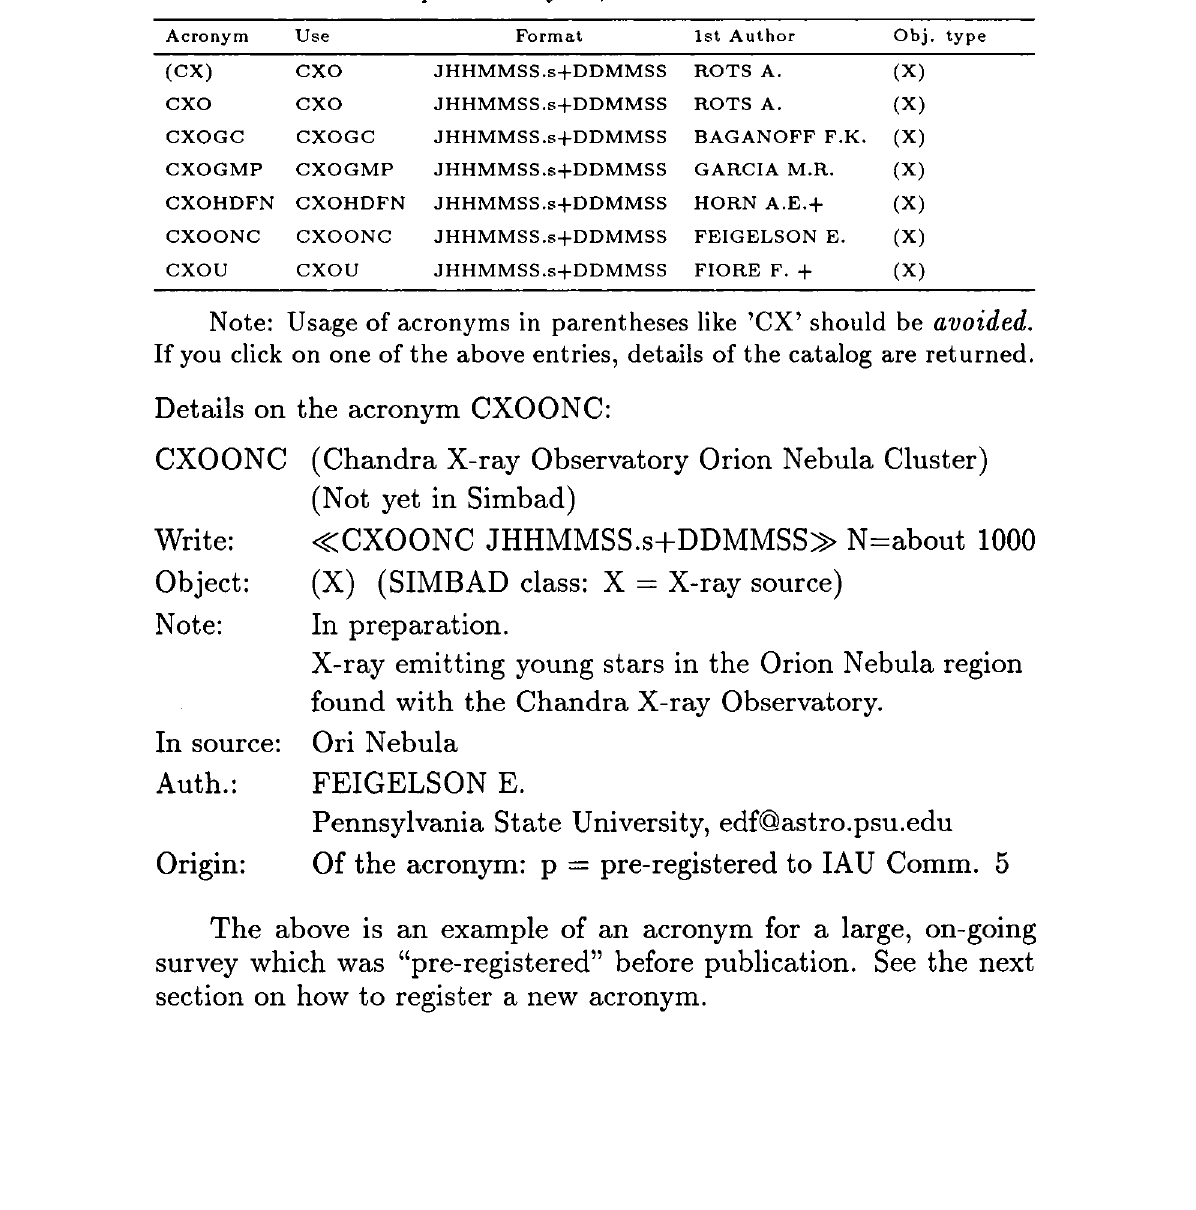
Table 1. Last CDS update: July 20,